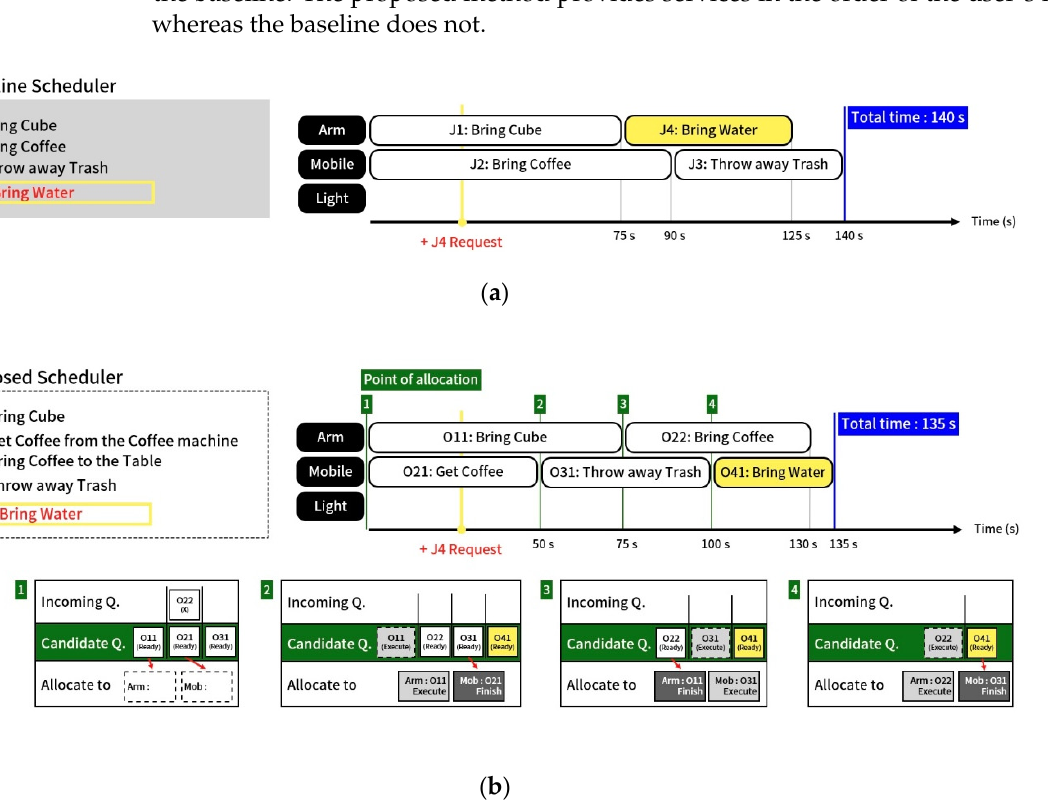
Figure 4. Additional job request: ( a ) the baseline scheduler and ( b ) the proposed scheduler.